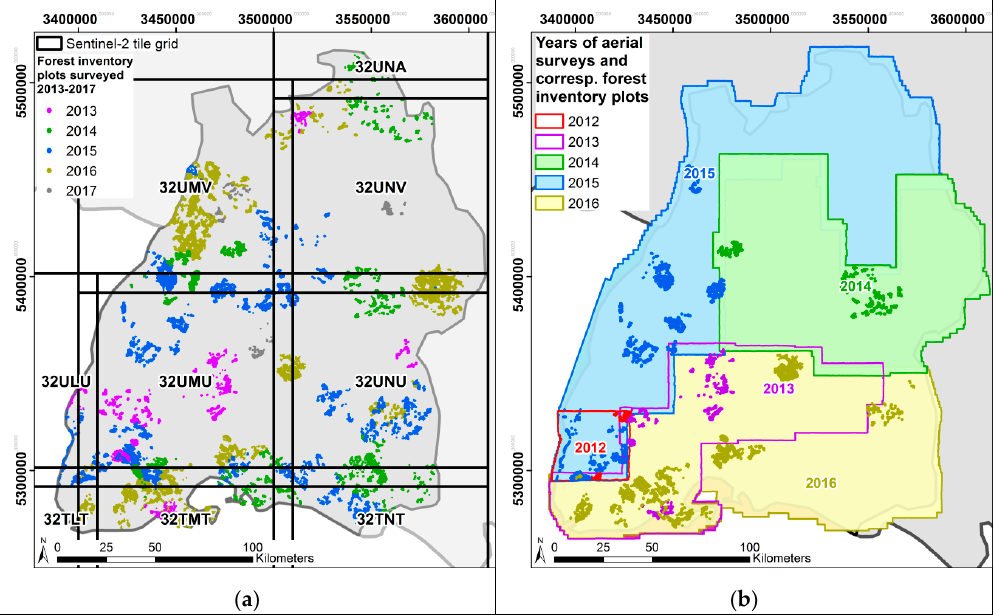
Figure 3. Remote sensing data in study area and corresponding forest inventory data: ( a ) Coverage of nine Sentinel 2 tiles; forest inventory data from the years 2013–2107 as used for modelling percentage of broadleaf trees are depicted as well ( n = 24,788); ( b ) coverage of the aerial surveys in the years 2012–2106; corresponding forest inventory plots from the same years as aerial surveys and as used for timber volume modelling are depicted as well ( n = 11,554).